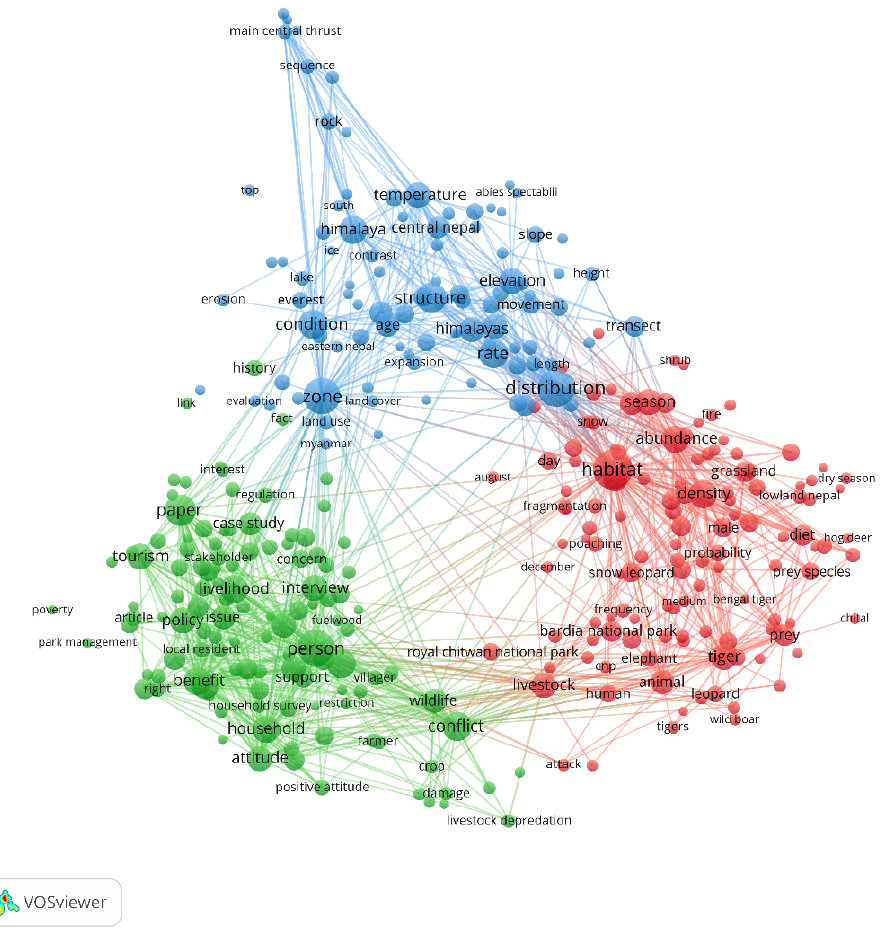
Figure 7. Mapping of “All Keywords”.